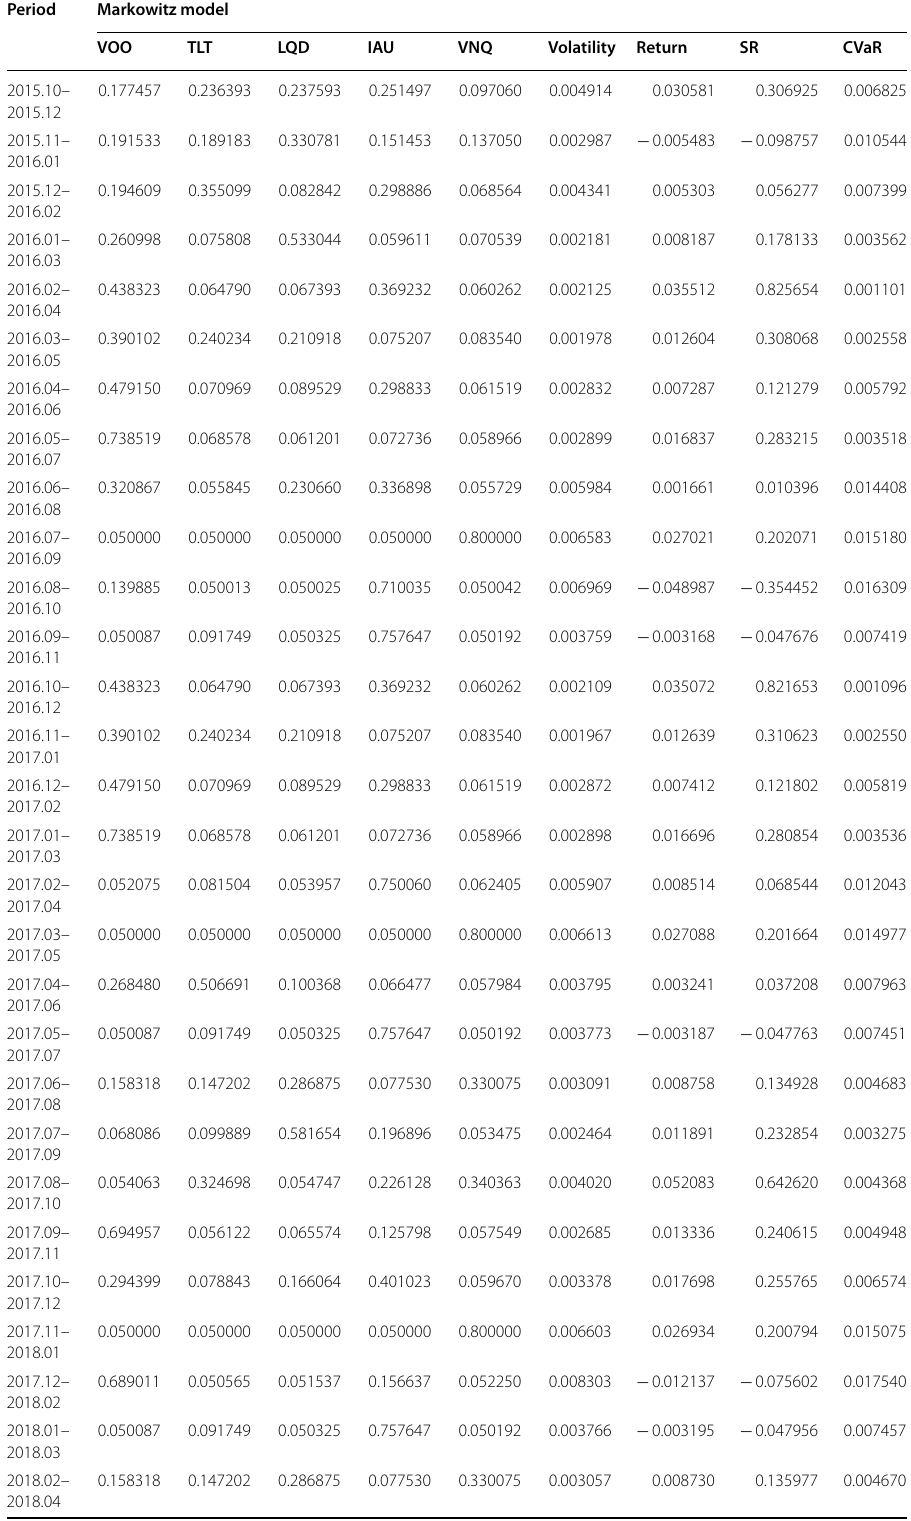
Table 3 The in‑sample results of Markowitz model and semiparametric method with CVaR